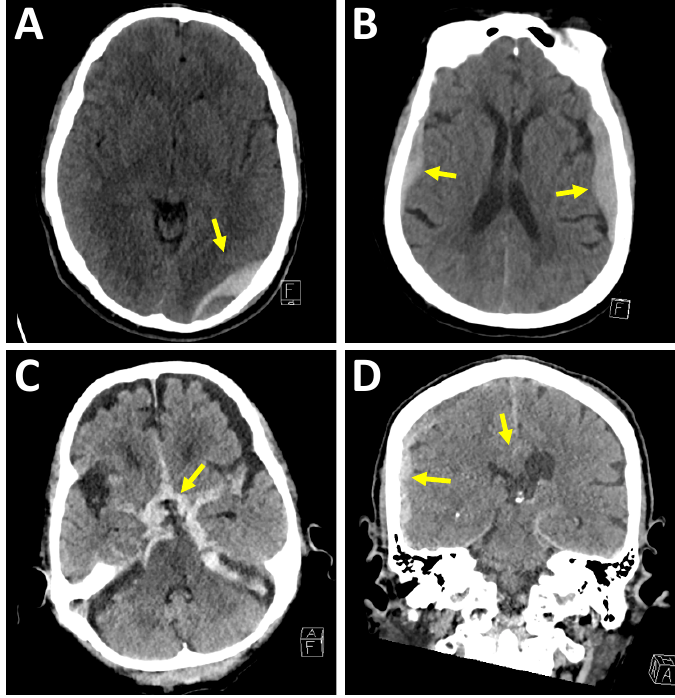
Figure 1. Extra-axial hemorrhage patterns. ( A ) Epidural hematoma. Thirty-three-year-old man was brought in by ambulance after a motor vehicle accident. Axial image demonstrates a biconvex shaped extra-axial fluid collection superficial to the left occipital lobe with hyperdense and hypodense components. Adjacent left temporal bone fracture not seen on this axial image. ( B ) Bilateral subdural hematomas. Seventy-three-year-old woman presented after a fall out of bed with dizziness. Axial image demonstrates bilateral crescentic shaped fluid collections, which were found to cross the coronal sutures. ( C ) Massive subarachnoid hemorrhage. Ninety-seven-year-old man on anticoagulation fell while walking. Axial image demonstrates a subarachnoid hemorrhage within the basal cisterns. Patient expired five days later due to cardiorespiratory failure. ( D ) Subdural hematoma with developing subfalcine herniation. Sixty-nine-year-old man on anticoagulation fell and struck his head. Coronal image demonstrates subdural hematoma along the right cerebral convexity with mass effect on adjacent lateral ventricle, midline shift, and subfalcine